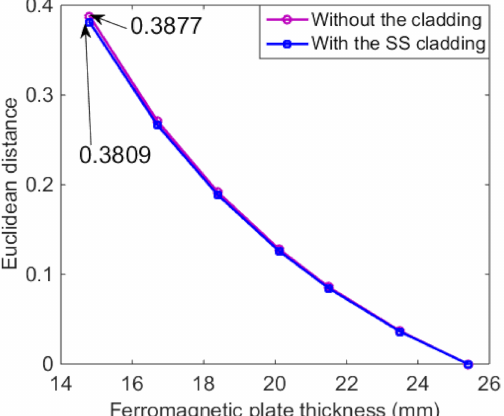
Figure 7. Euclidean distances obtained with and without the SS cladding.